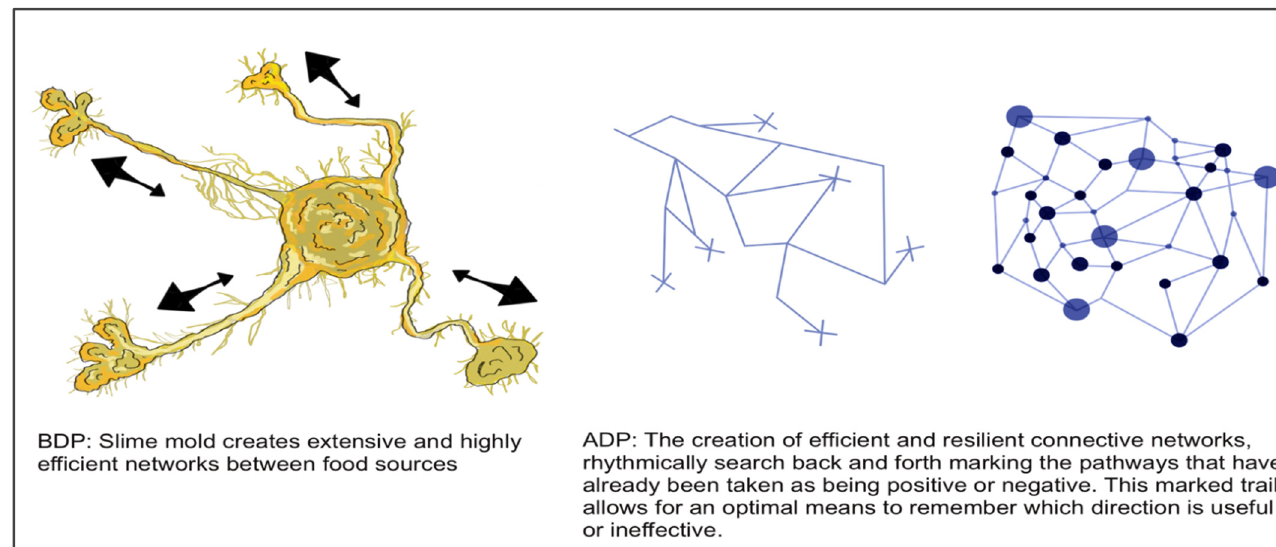
Figure 4. BDP and ADP diagram of slime mold—I. Rössler and C.Whitehead, 2021 cohort.